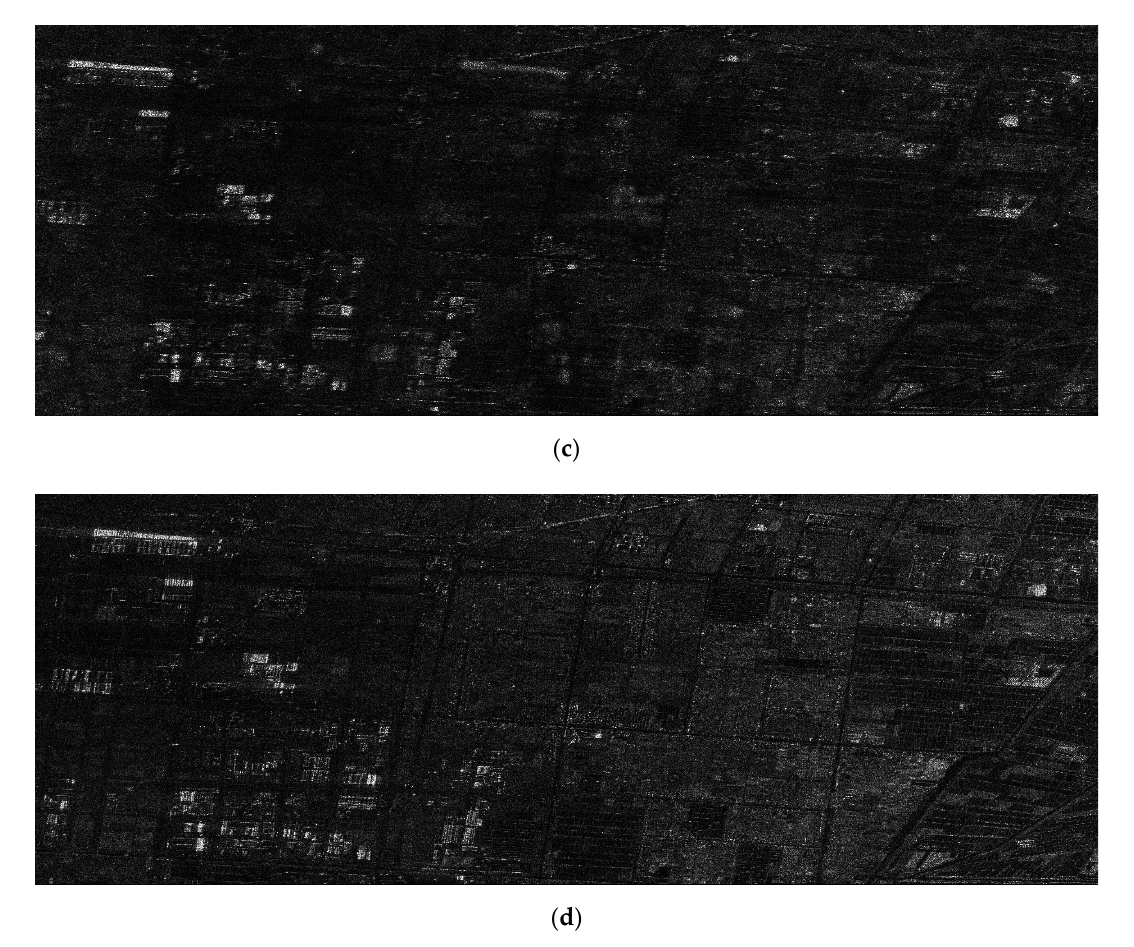
Figure 8. Comparison of scene simulation results. ( a ) Imaging results of the traditional method with a velocity of 2 m/s and an acceleration of 5 m/s 2 . ( b ) Imaging results of the traditional method with a velocity of 1 m/s and an acceleration of 1 m/s 2 . ( c ) Imaging results of the traditional method with a velocity of 1 m/s and an acceleration of 0.1 m/s 2 . ( d ) Imaging results of the proposed method with a velocity of 2 m/s and an acceleration of 5 m/s 2 .